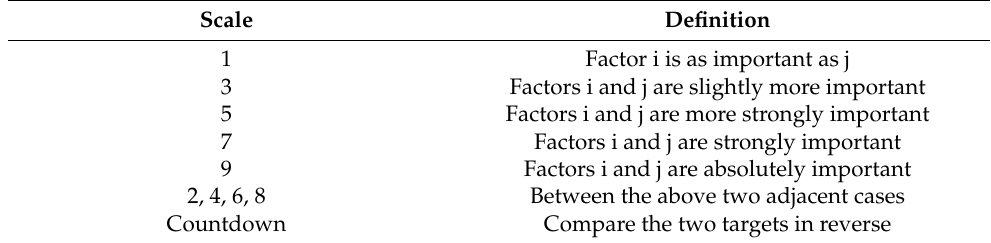
Table 1. Judgment matrix scales and their definitions. Scale Definition 1 Factor i is as important as